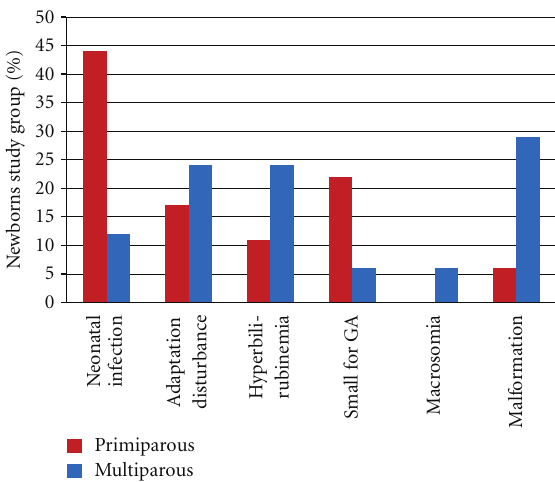
Figure 1: Percentage distribution of the reasons for referral of newborns in a paediatric hospital ( n = 35). Preterm births are not